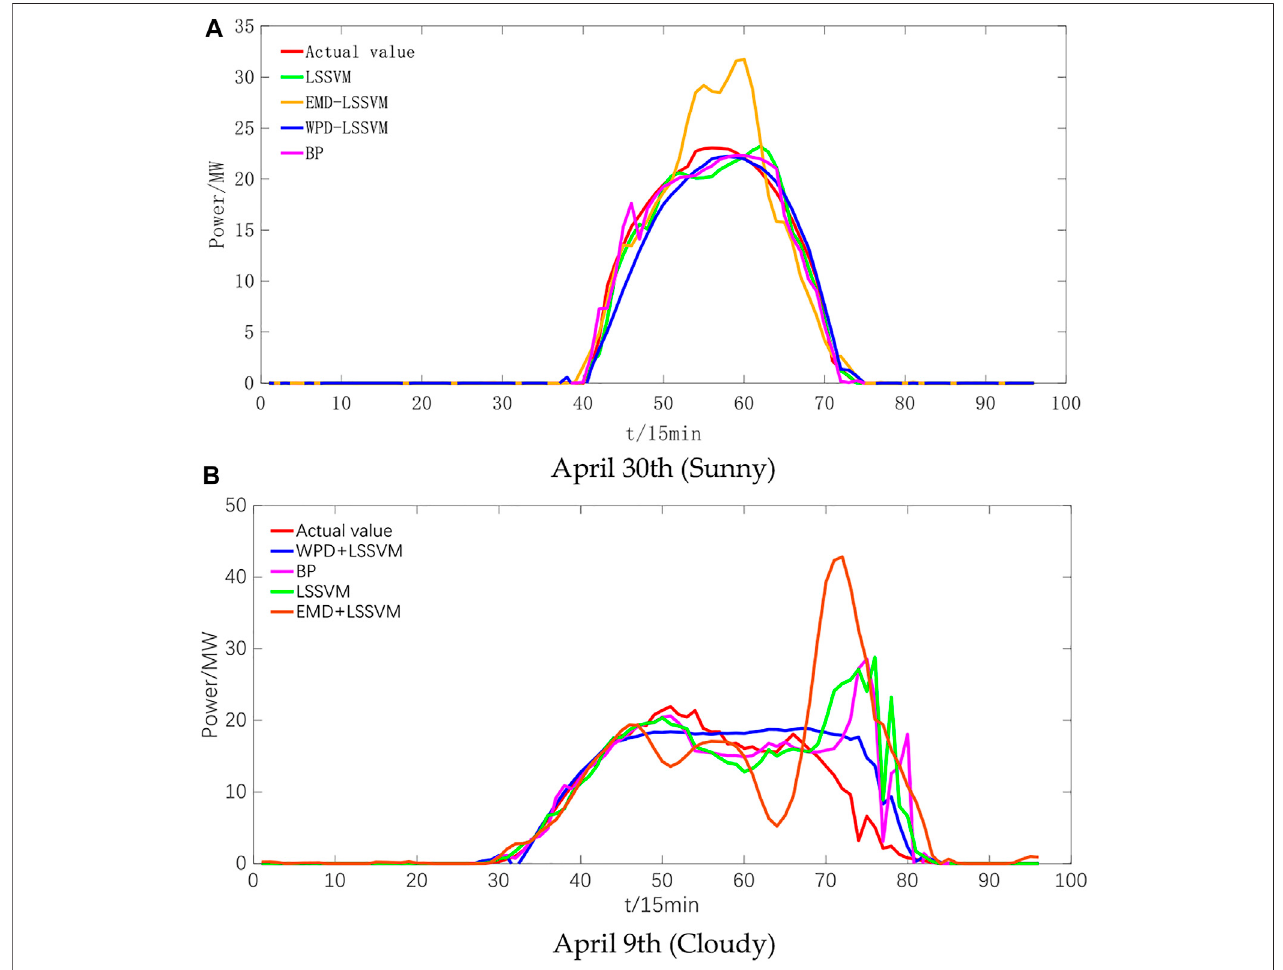
FIGURE 6 | PV power forecast values for different weather types. (A) April 30th (Sunny) (B) April 9th (Cloudy).